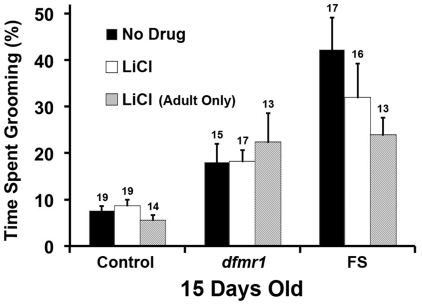
Lithium does not significantly affect grooming in dfmr1 mutant flies.Grooming activity of 15 day-old flies grown as larvae and maintained as adults, or only maintained as adults on food containing 5 mM LiCl. Data are presented as the mean percentage of time single flies spend grooming during a 5 min period (Mean +/- SEM); sample sizes are displayed above each bar. For all genotypes, LiCl causes no significant change in grooming activity (Kruskal-Wallis one-way ANOVA with Dunn's post-hoc comparison).